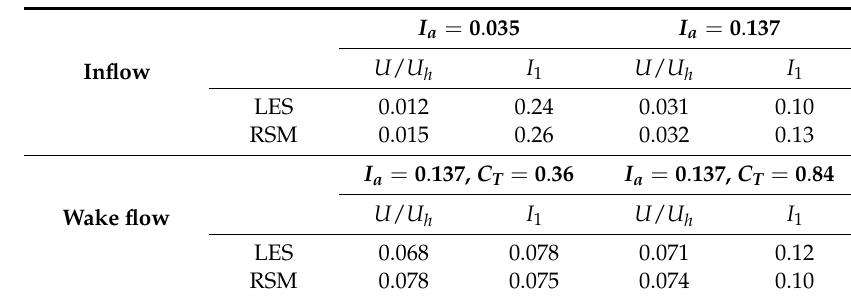
Table 3. NRMSE of simulated profiles respect to experimental data: Inflow for the result in Figure 4 and Wake flow for the result in Figure 5.